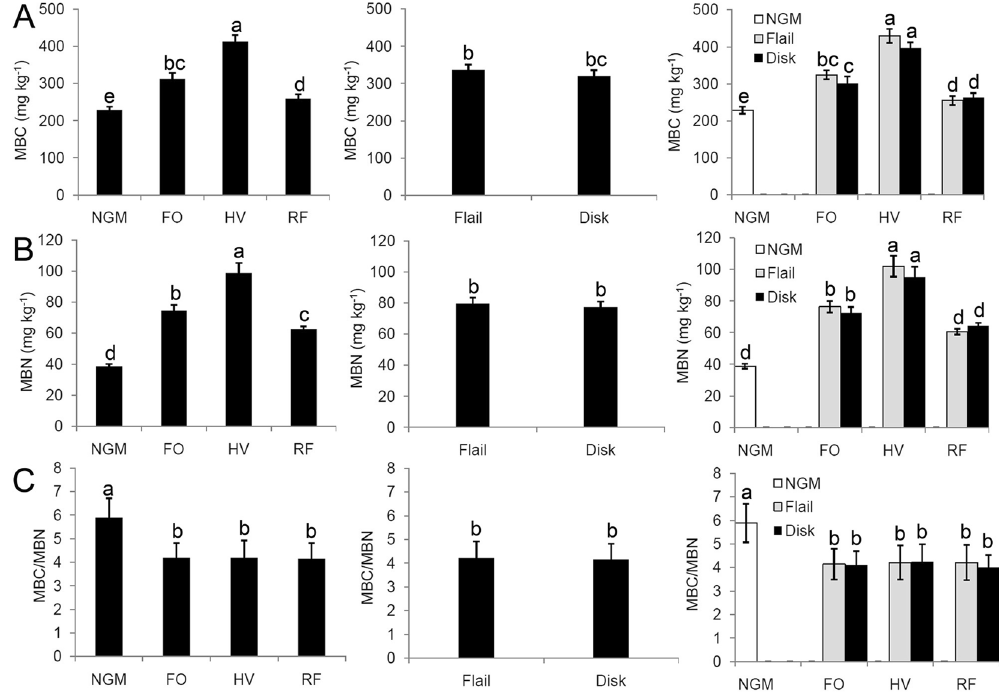
Figure 2. Soil microbial biomass as affected by both the green-manure treatment and termination method. ( A ) Microbial biomass carbon (MBC), ( B ) microbial biomass nitrogen (MBN) and ( C ) MBC/MBN. Bars with different letters differ significantly according to the LSD test ( P < 0.05). The P values of ANOVA are shown in Table S3. GM Green manure; FO February orchid; HV hairy vetch; RF rattail fescue; NGM no green manure. The histogram was created using Microsoft Excel 2010 (Microsoft, Redmond, Washington, USA).